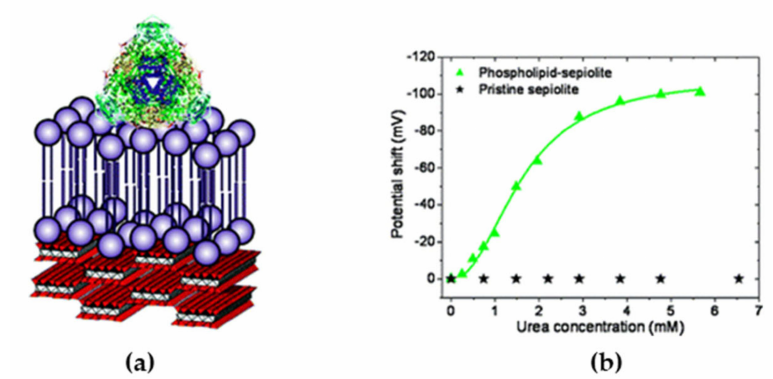
Figure 6. ( a ) Schematic representation of urease attached to a sBLM on sepiolite fiber. ( b ) Dependence on urea concentration of the potential shift of the redox probe as a result of pH increase due to the catalytic activity of urease immobilized on pristine and sBLM-modified sepiolite. Reproduced with permission from [88]. Copyright (2011) American Chemical